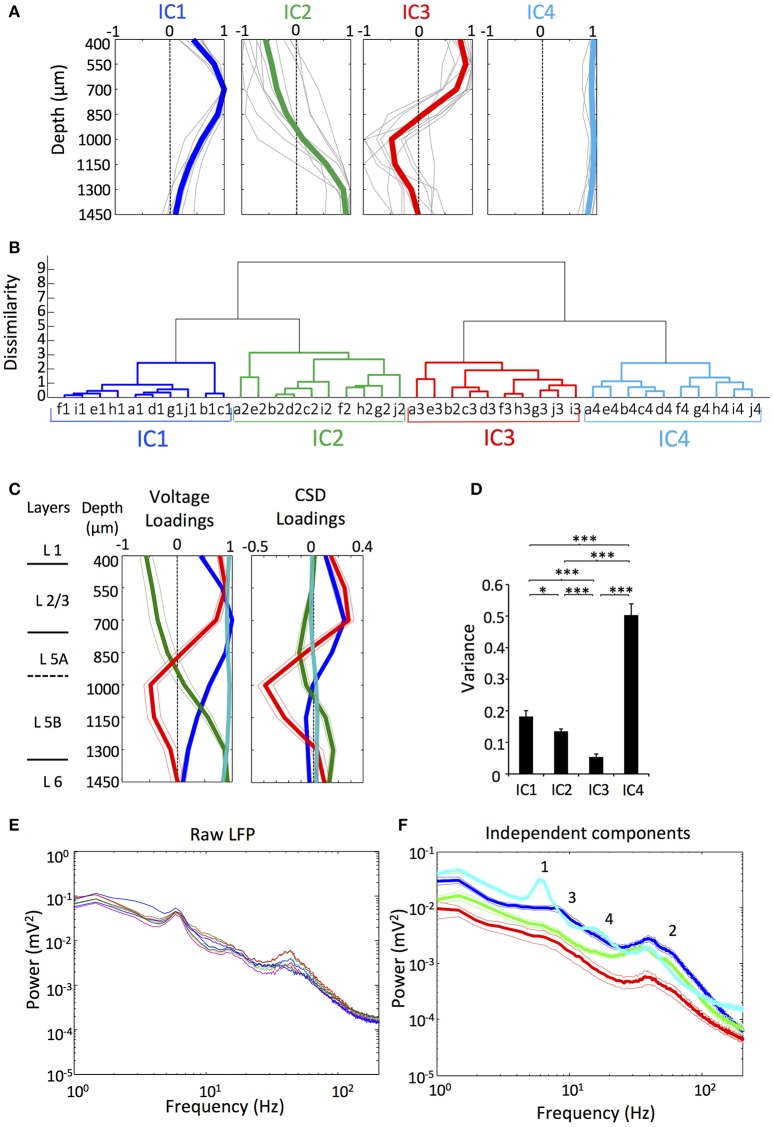
There were four main ICs of the LFP in the motor cortex. (A) Normalized voltage loadings of the four main ICs. Colored lines represent the mean value and gray lines represent the voltage loadings of different rats (n = 10). (B) Cluster analysis of the voltage loadings from 10 rats (a-j) established four different groups corresponding to the four different ICs. n = 10. (C) Mean Normalized voltage loadings (Left) and CSD loadings (Right) of the ICs from all the animals and the previously obtained scheme of the approximate layer-depth correspondence for the primary motor cortex (Isomura et al., 2009; Hooks et al., 2013). n = 10. (D) The variance of the ICs showed the differential contribution to the LFP. n = 9. (*/***p < 0.05/0.01/0.001; t-test). (E) Representative power spectra of the raw LFP in the motor cortex of an animal as was established previously by Igarashi et al. (2013). Each colored line represents an electrode with different depth. (F) Mean power spectra of the ICs. Numbers 1–4 indicate various relevant features of the profiles (see section Results). n = 9.